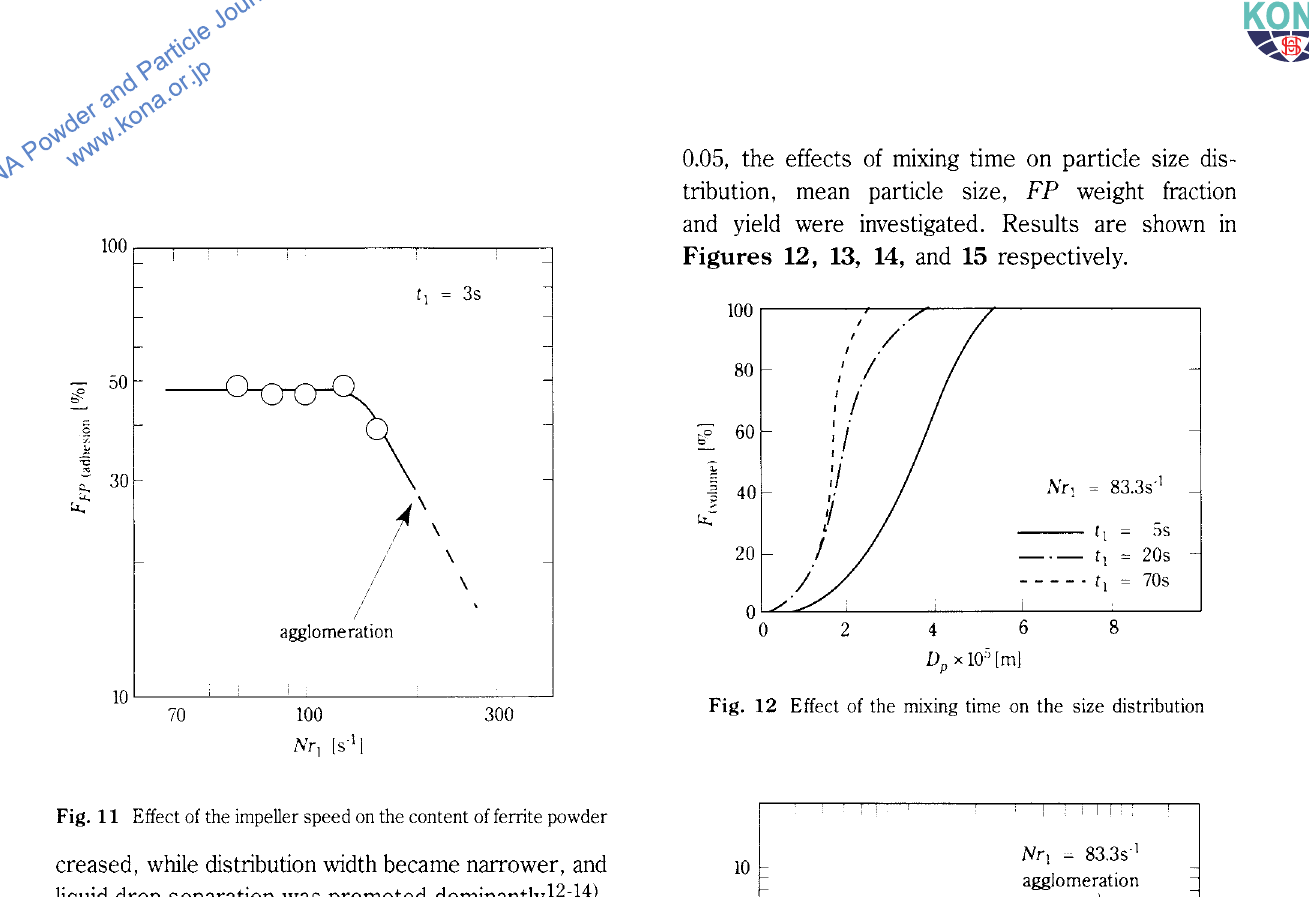
Fig. 12 Effect of the mixing time on the size distribution